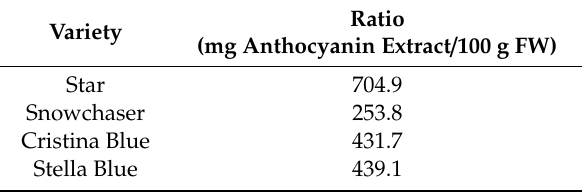
Table 1. Ratio of anthocyanin extract obtained from each blueberry variety.